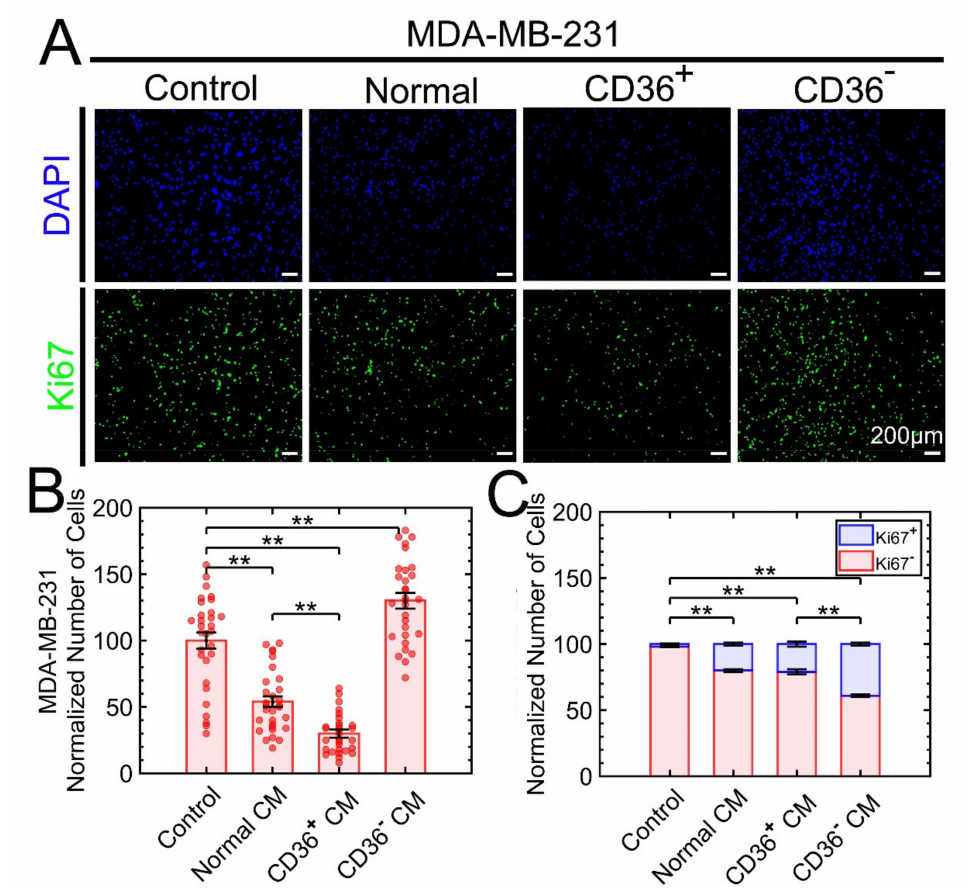
Figure 1. The 3D growth of MDA-MB-231 is suppressed as a result of exposure to the CM from CD36 + FBs. ( A ) The number of cells (DAPI) and their proliferation status (Ki67) is monitored and visualized by fluorescent microscopy under control and exposure to the CM from normal, CD36 + , or CD36 − FBs. ( B ) The number of cells was quantified for each condition based on the nuclear counterstain. ( C ) Frequency of low and high expressing Ki67 cells was quantified for each condition. For ( B , C ), quantitative data were normalized to control (untreated cells). ** p <